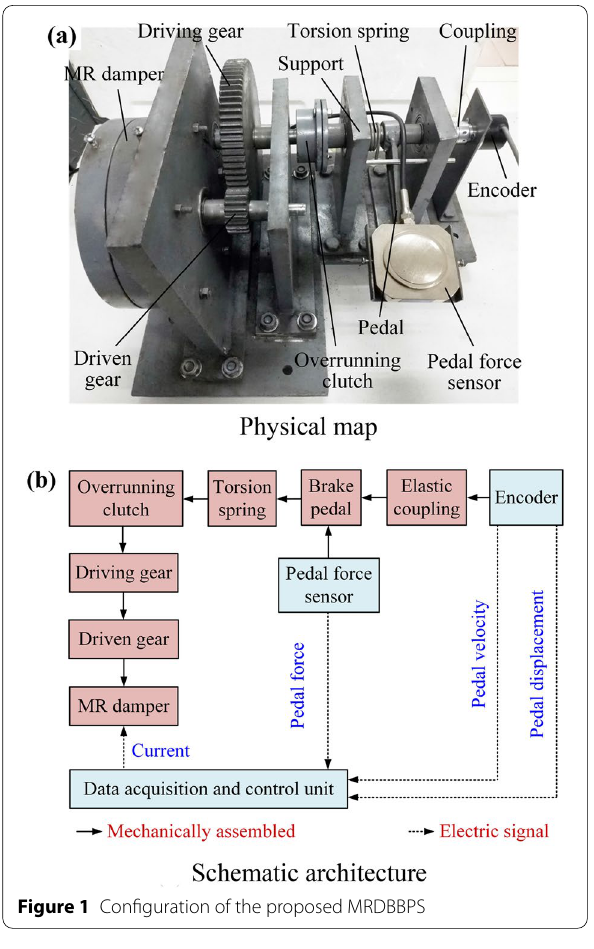
Figure 1 Configuration of the proposed MRDBBPS